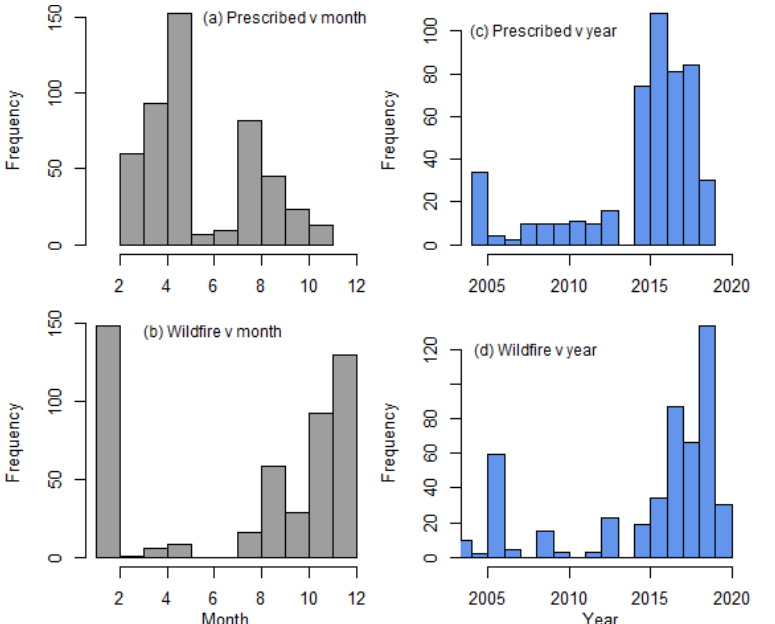
Figure 1. Map of smoke plume frequency for 2002–2020 for ( a ) prescribed burns and ( b ) wildfires. The Greater Sydney area is outlined in black. High density in b is centered on Wollemi National Park. Notice the different scales for the shading.